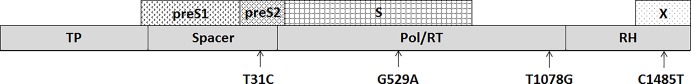
Schema of the polymerase region and overlapping preS, S, and X regions.